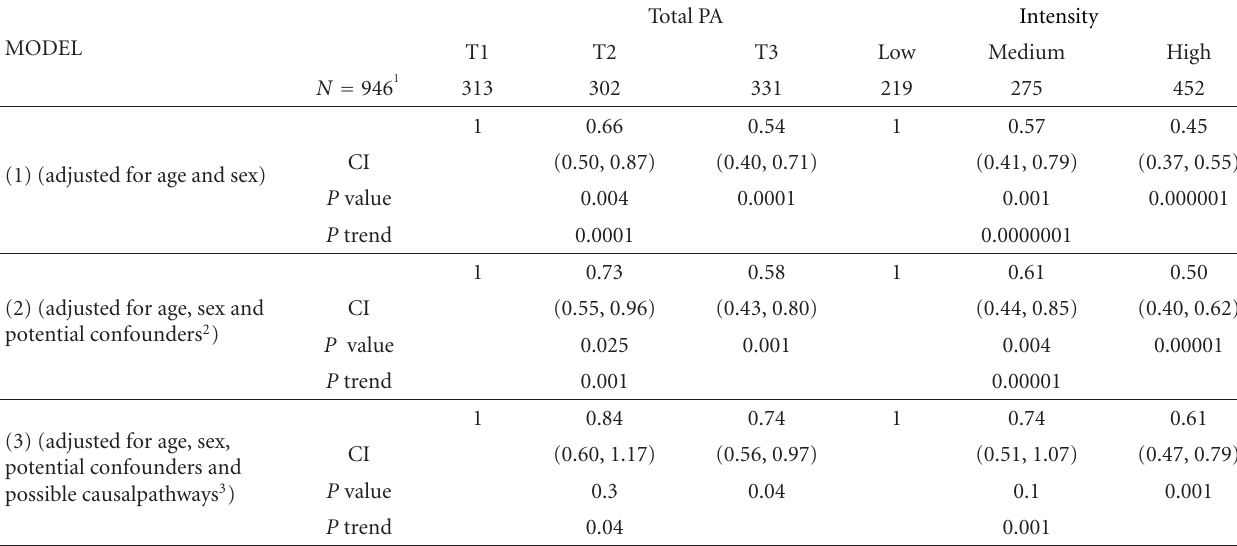
Table 5: Hazard ratios (95% CI, P value) by tertile of total PA and category of intensity referent to the first tertile/category.